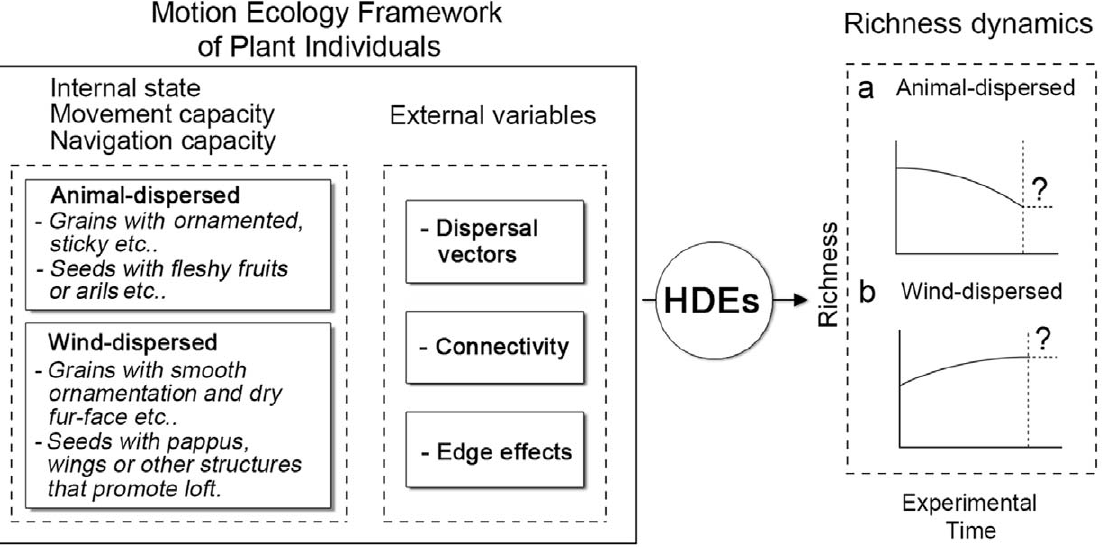
Figure 2. Predictions of animal- and wind-dispersed species in richness dynamic for our experimental landscapes (modified from [ 11,12 ] ). The dashed lines exceed our experimental time and relax to an unknown trend. We cannot make predictions about them.